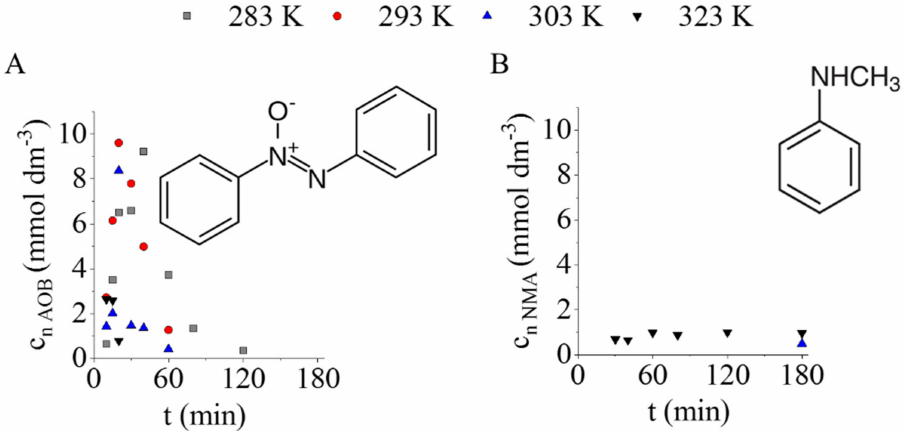
Figure 6. The concentration of azoxybenzene (intermediate) ( A ) and N -methylaniline by-product ( B ) vs. time of hydrogenation at various